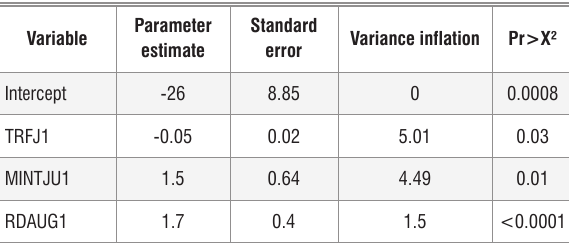
Parameter estimates of a logistic regression model used to explain white mold incidence (≥20%) in dry bean crops in North Dakota, USA, during 2003 to 2005